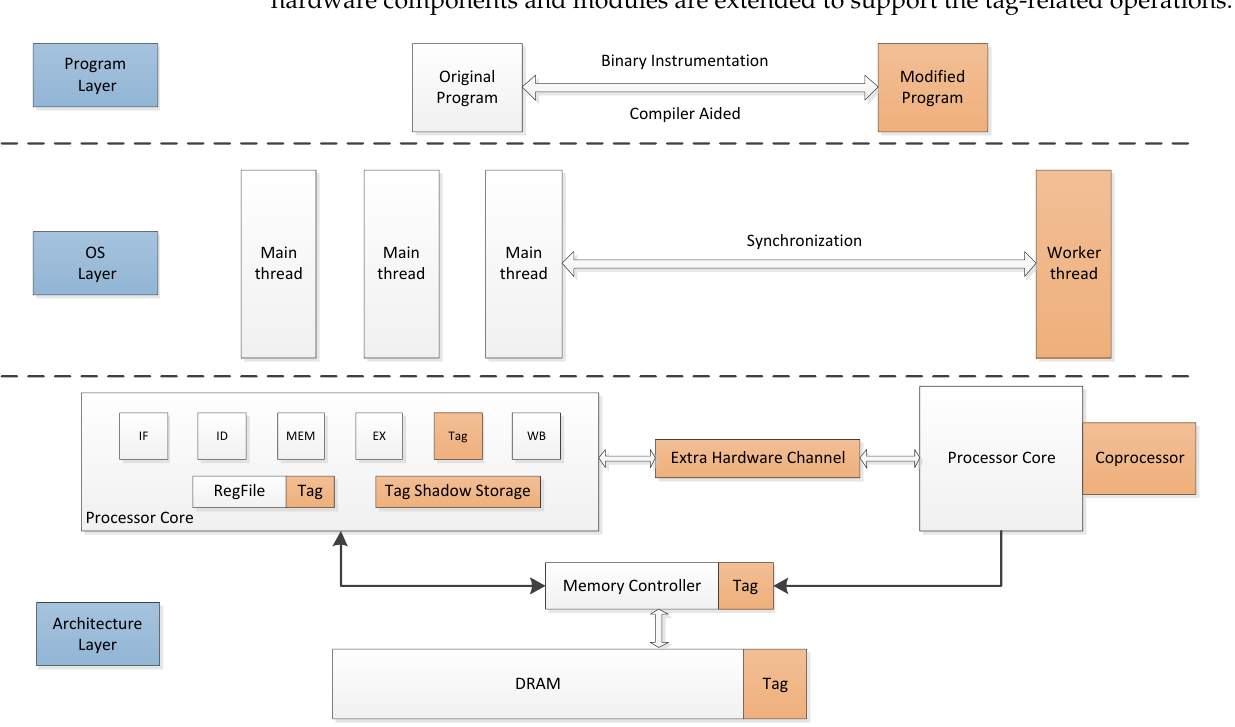
Figure 1. The DIFT works on different layers of whole